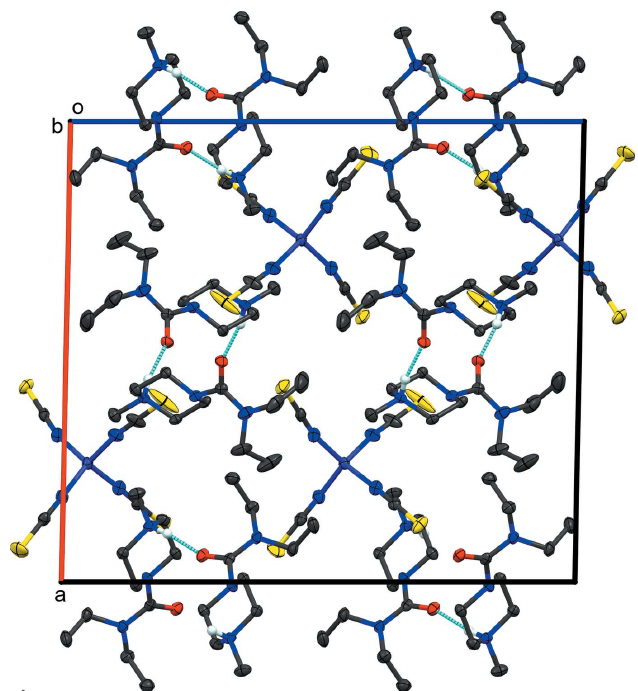
Figure 2 Packing diagram of bis(diethylcarbamazide) tetrakis(isothiocyanato)- cobalt(II) viewed along the b -axis. Hydrogen atoms, except for those involved in hydrogen bonding, have been omitted for clarity. Blue dashed lines represent hydrogen-bonding